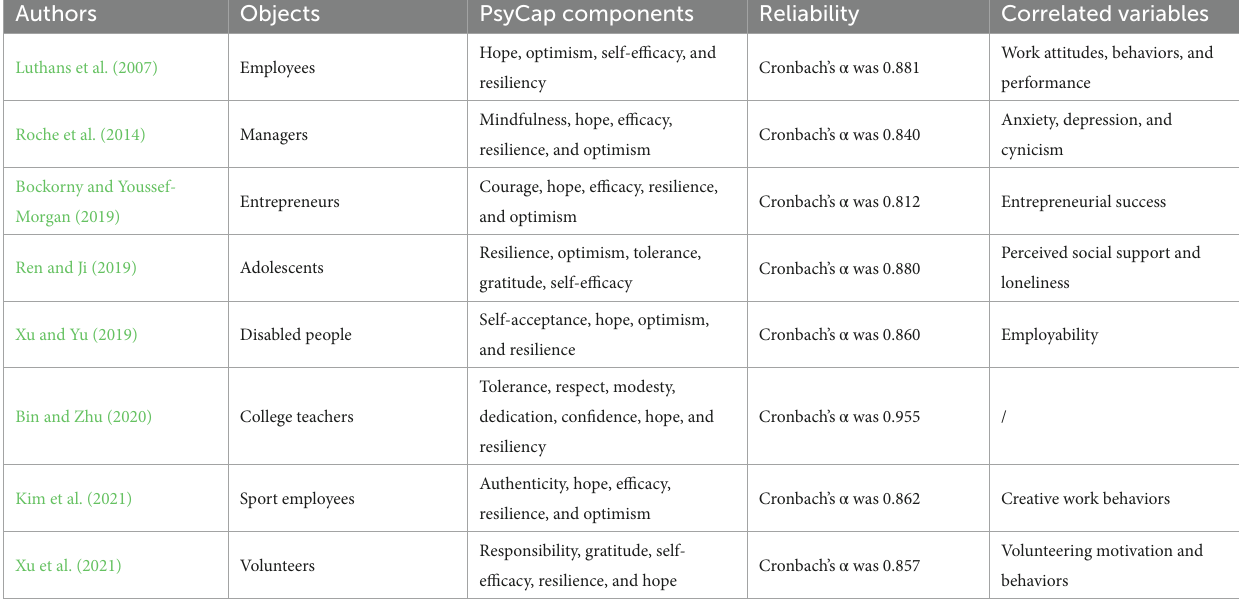
TABLE 1 PsyCap scales of different research objects in the previous studies.